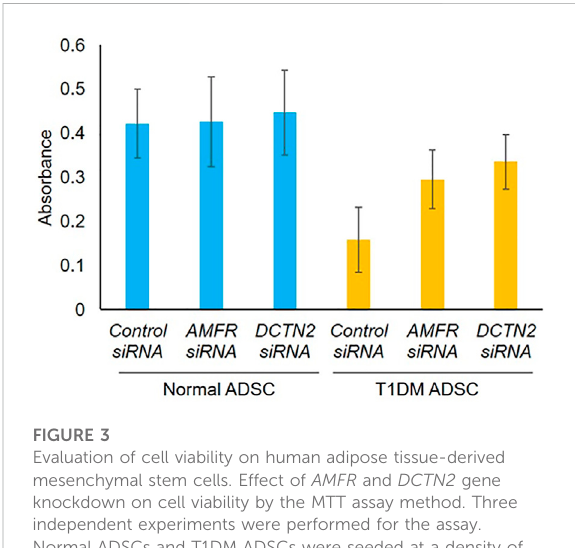
FIGURE 3 Evaluation of cell viability on human adipose tissue-derived mesenchymal stem cells. Effect of AMFR and DCTN2 gene knockdown on cell viability by the MTT assay method. Three independent experiments were performed for the assay. Normal ADSCs and T1DM ADSCs were seeded at a density of 2000 cells/cm 2